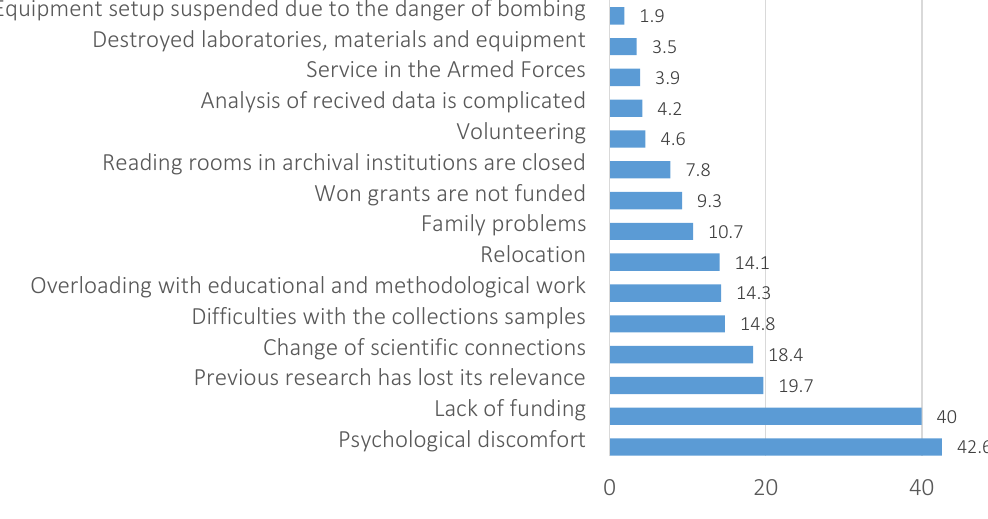
Figure 1. Answers to the question “How exactly did the war prevent you from conducting scientific